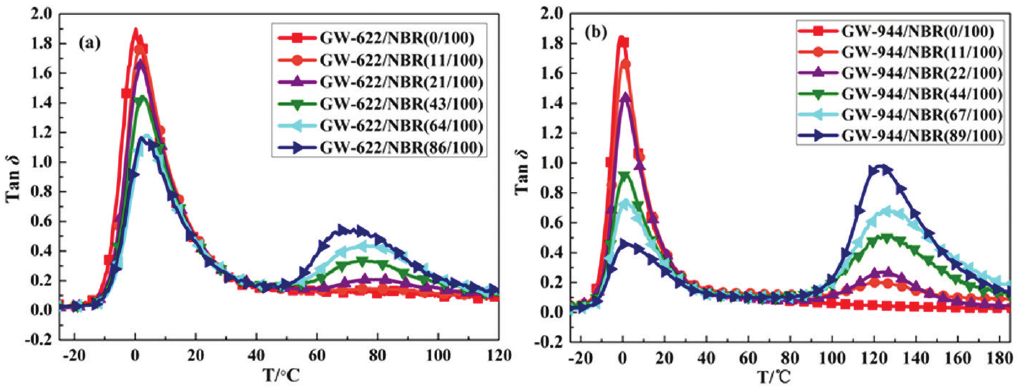
Figure 5: Temperature dependence of loss tangent (tan δ ): (a) GW-622/NBR composite and (b) GW-944/NBR